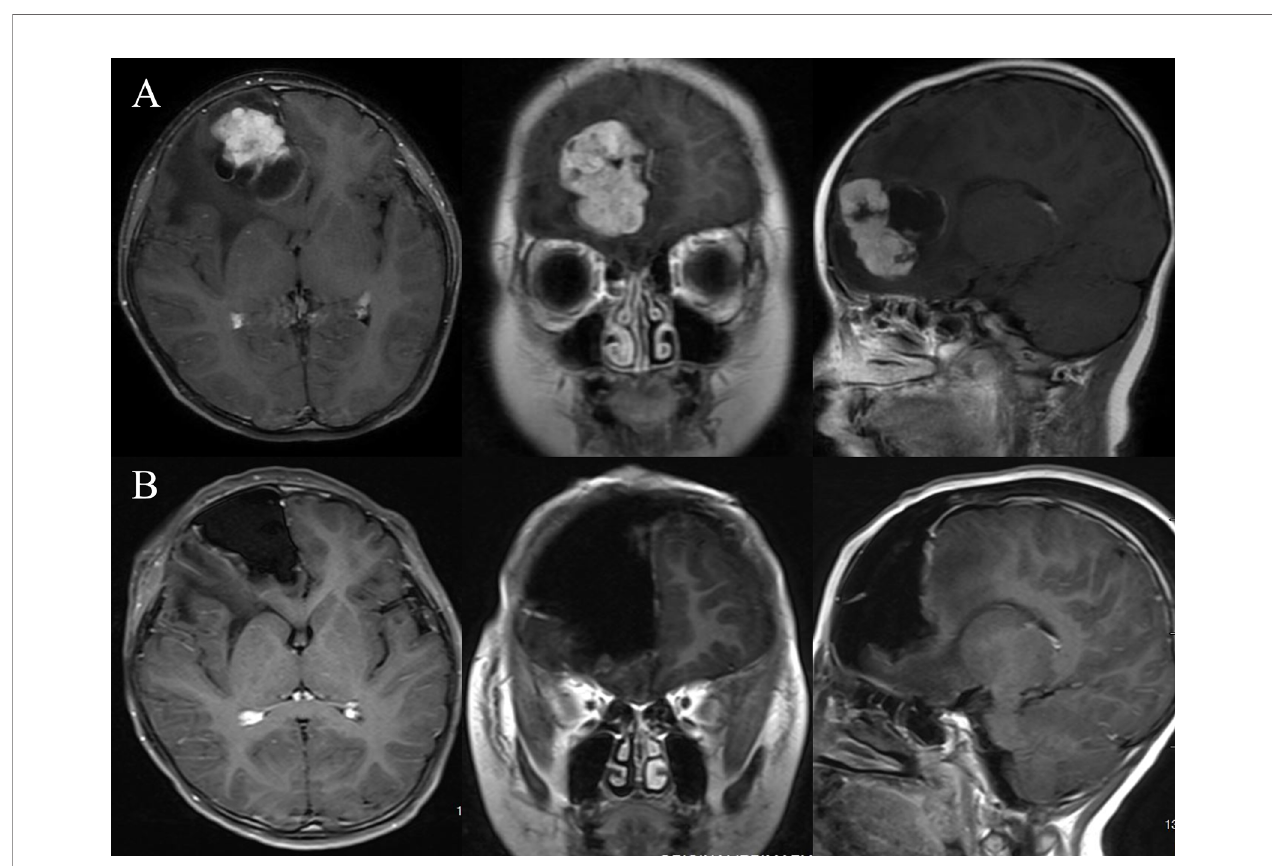
FIGURE 1 | Illustrative case No. 3. A 9-month-old boy presented with headache and vomiting for one week and a contrast-enhanced lesion at the right frontal (A) . The tumor was total resected using the right frontal craniotomy approach (B) .